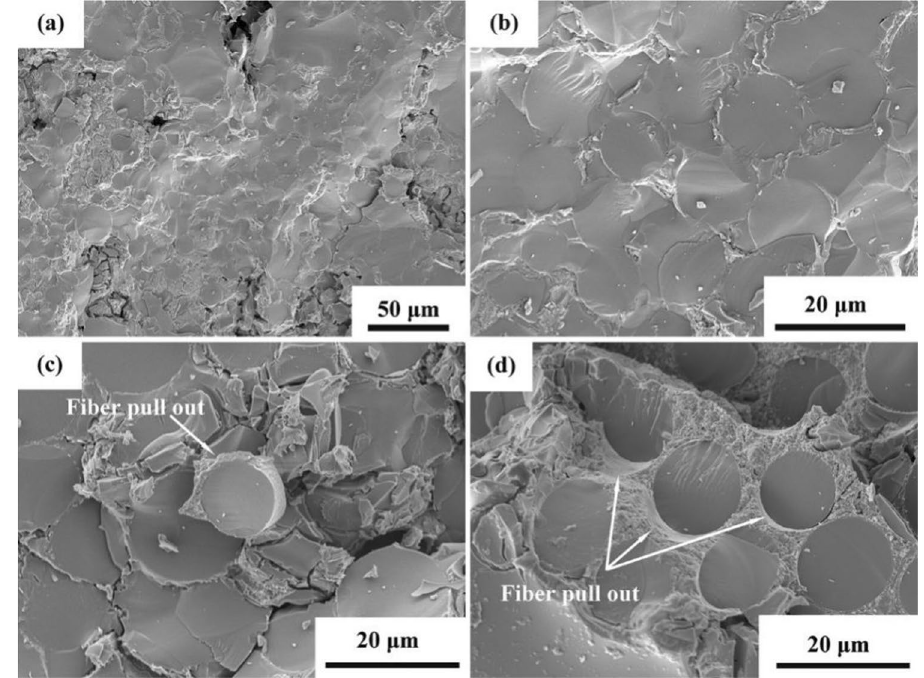
Figure 7. High-magnification fracture surface of SiC f /SiC minicomposites: ( a , b ) without interphase coating and ( c , d ) with CaWO 4 interphase